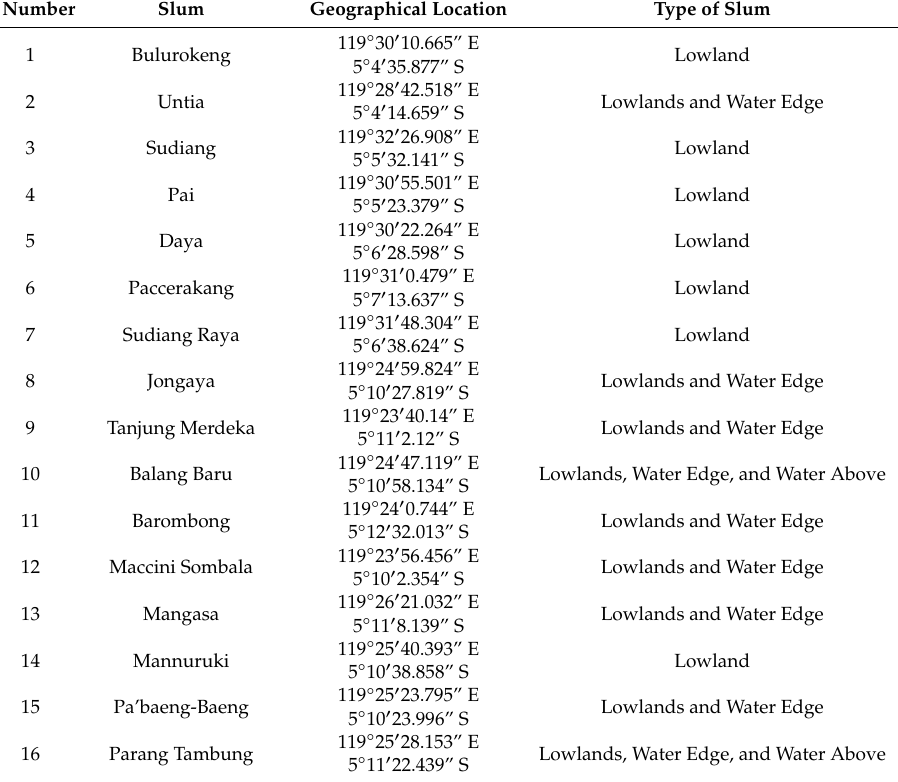
Figure 3. The study objects: Biringkanaya and Tamalate Districts in Makassar. Table 1. Geographical position and types of slums in the study